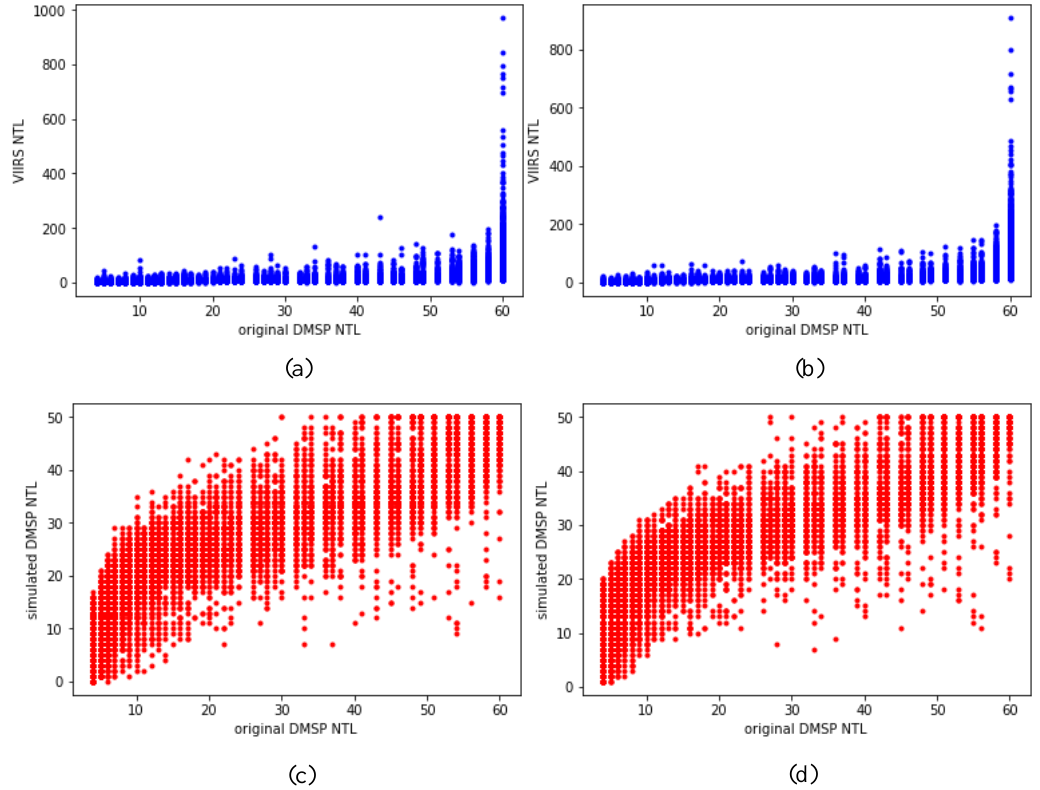
Figure 10. Distribution of pixel values of NTL in 2012 and 2013. Distribution of pixel values of original DMSP and VIIRS annual composites in 2012 ( a ) and 2013 ( b ), and original DMSP and simulated DMSP annual composites in 2012 ( c ) and 2013 ( d ).